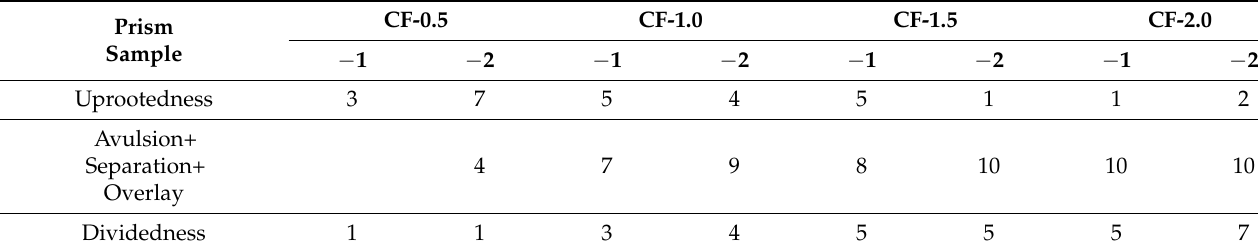
Table 2. Numbers of combined